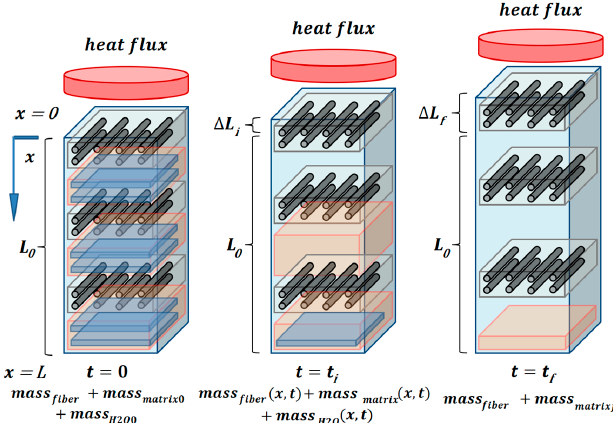
Figure 10. Schematic of hygro-thermal expansion modeling of a laminated composite material. Each volume element is formed by fibers, matrix resin, porosity, and water (free and bonded).